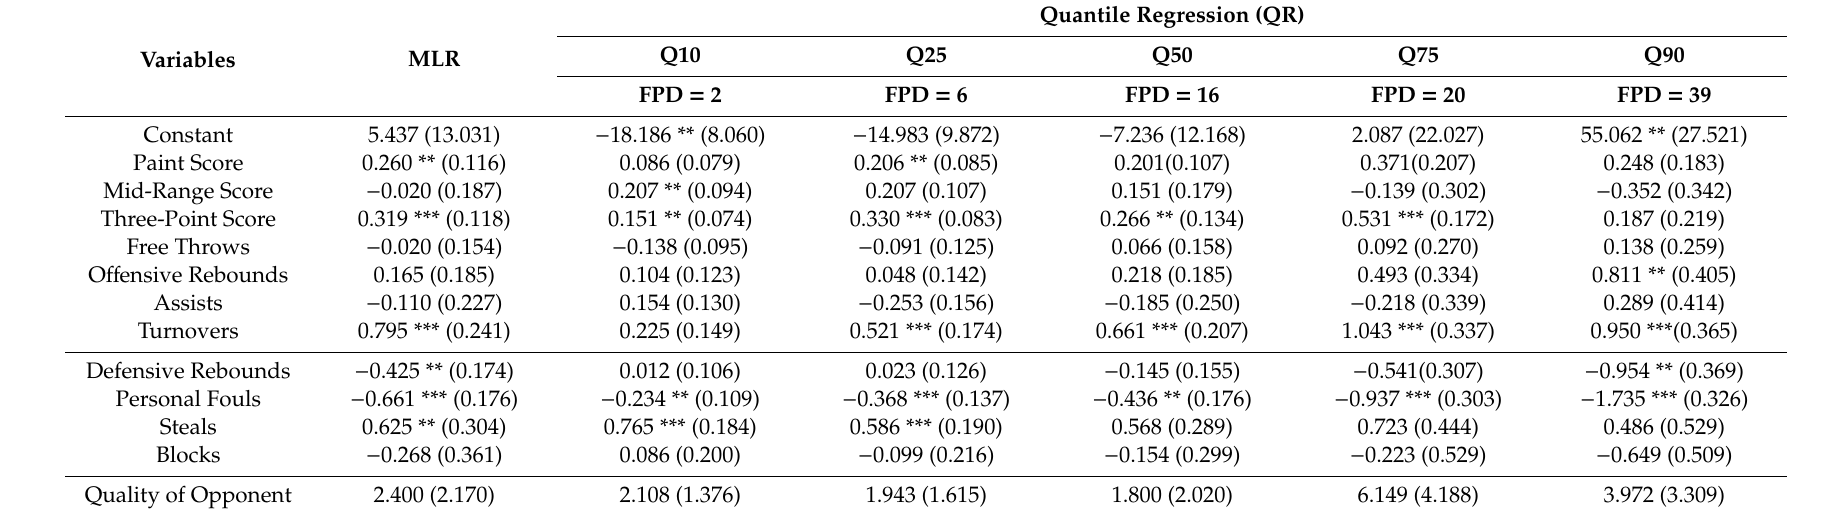
Table 2. Parameter estimates from multiple linear regression (MLR) and quantile regression (QR) on final score di ff erence